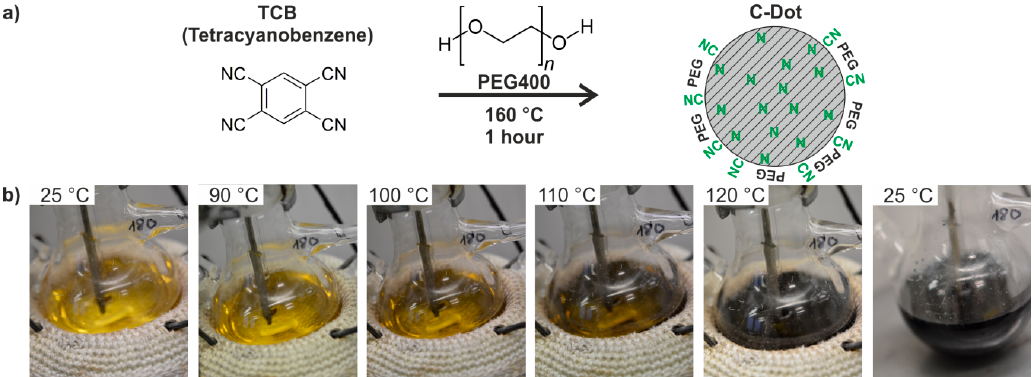
Figure 1. Polyol-mediated synthesis of C-dots with 1,2,4,5-tetracyanobenzene (TCB) in polyethylene glycol 400 (PEG400): ( a ) scheme of the synthesis of nitrogen-containing C-dots with PEG surface functionalization; ( b ) course of the reaction and color change at 100 to 120 °C while heating a solution of TCB in PEG400 from room temperature to 160 °C as well as dark black C-dot suspension after cooling to room temperature.